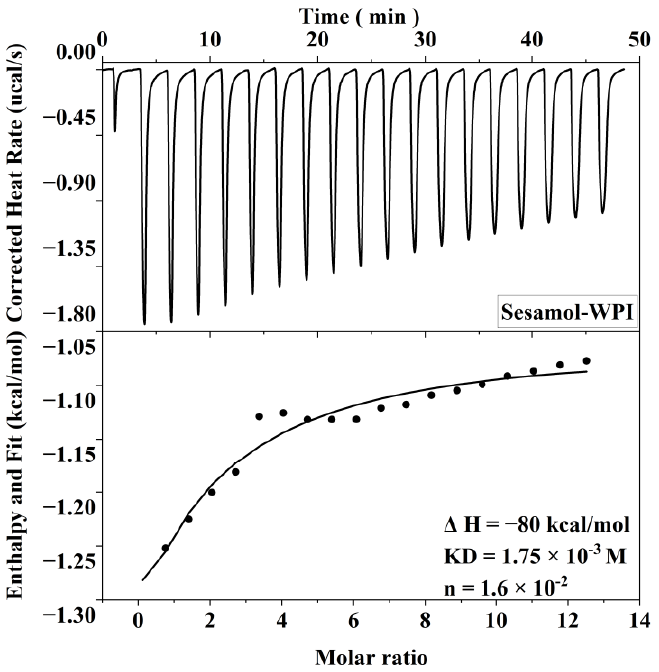
Figure 5. Correction heat rate versus time and enthalpy change corresponding to 20 mM sesamol titration of 0.3 mM WPI.